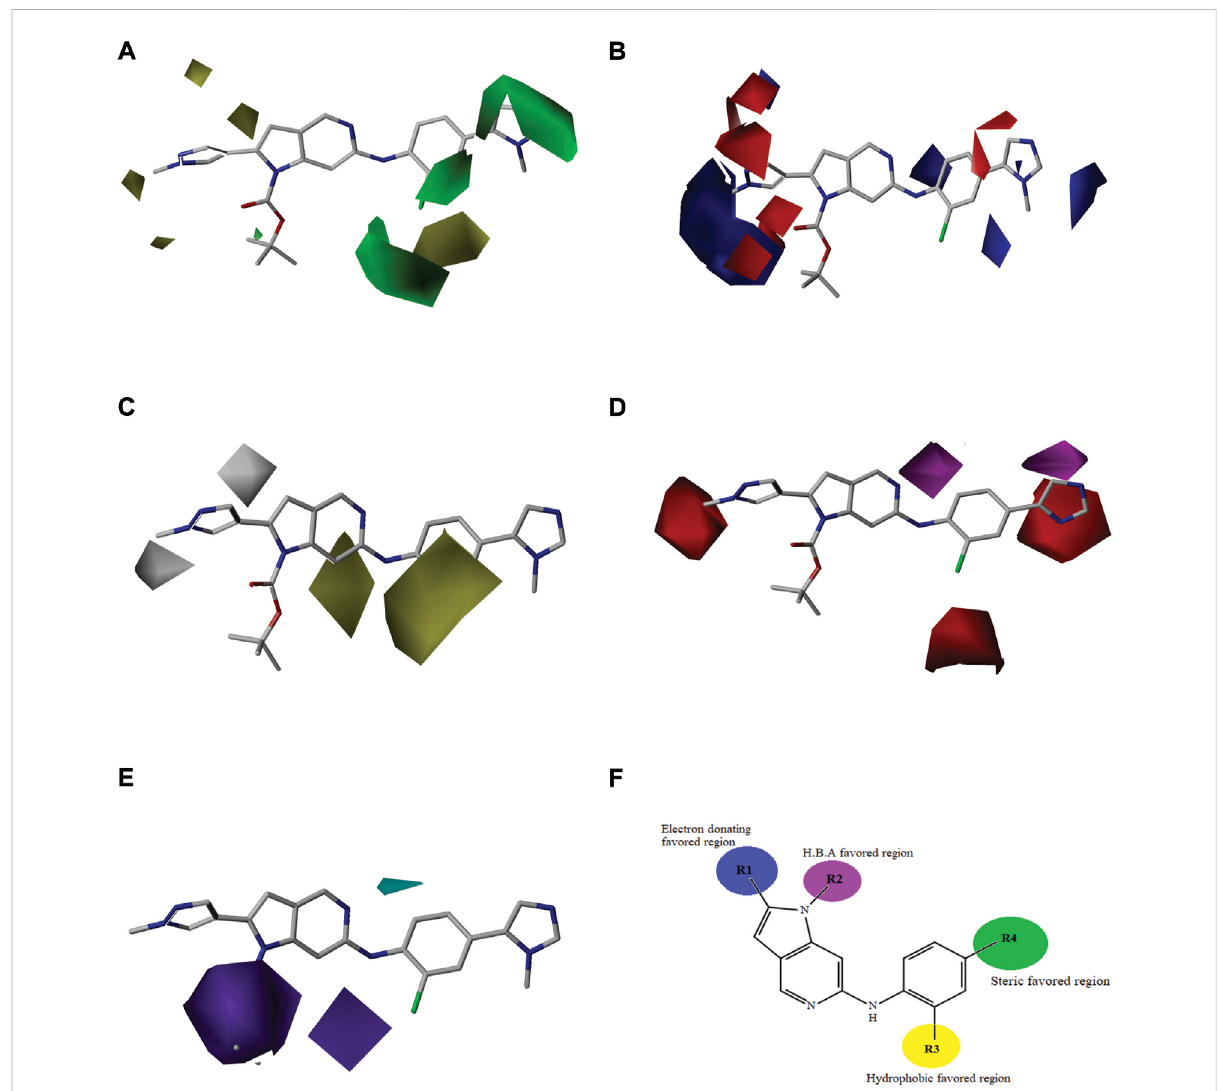
FIGURE 3 “ Structure-based model of the most active compound represented through contour maps (36). (A) Contour maps of CoMFA steric fi eld; (B) ContourmapsofCoMFAelectrostatic fi elds; (C) ContourmapsofCoMSIAhydrophobic fi eld; (D) ContourmapsofCoMSIAhydrogenbondacceptor fi elds; (E) Contour maps of CoMSIA hydrogen bond donor fi elds; (F) Structure activity relationship representation of contour groups.